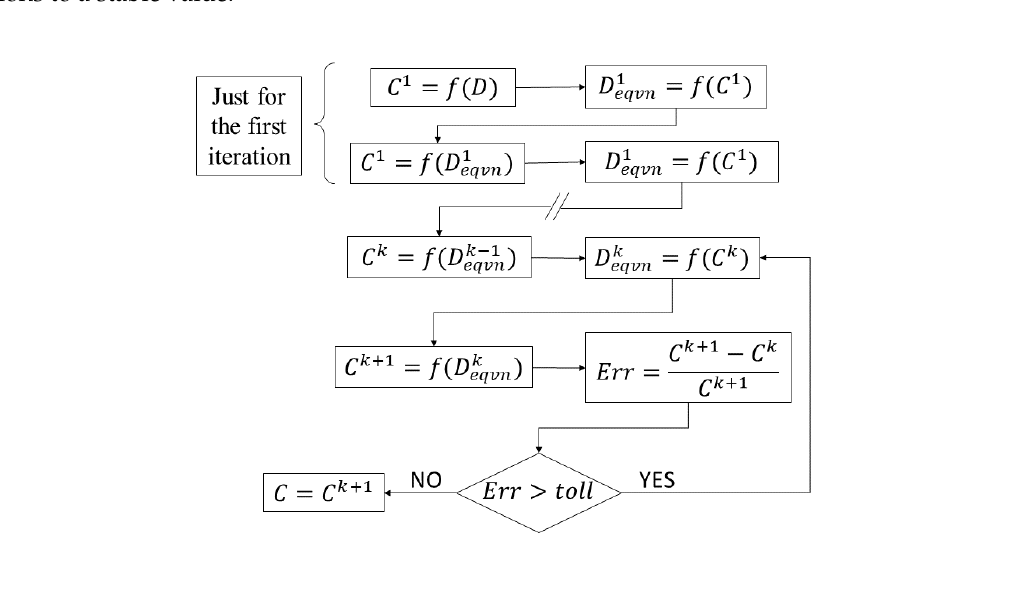
Figure 2. Iterative calculation